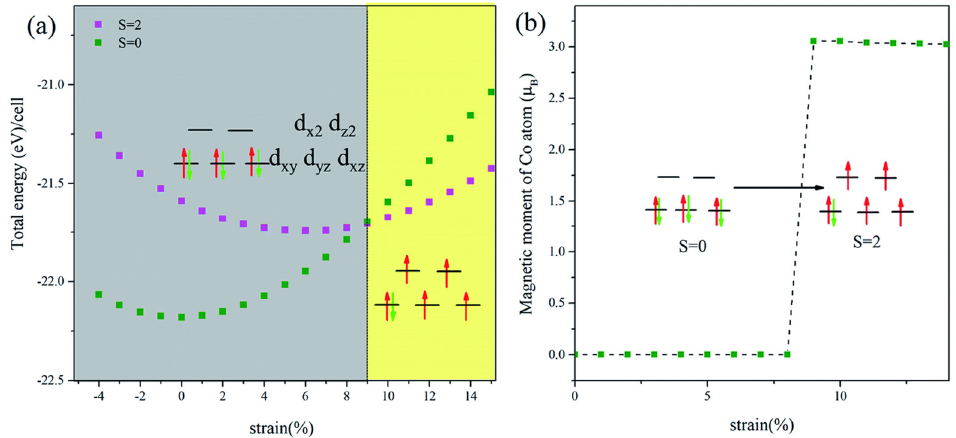
Figure 32. ( a ) The total energy of CoOOH versus strain and ( b ) magnetic moment of Co 3+ ions versus strain. (Reprinted from ref. [198] with permission from Journal of Materials Chemistry A © 2021, Royal Society of Chemistry).